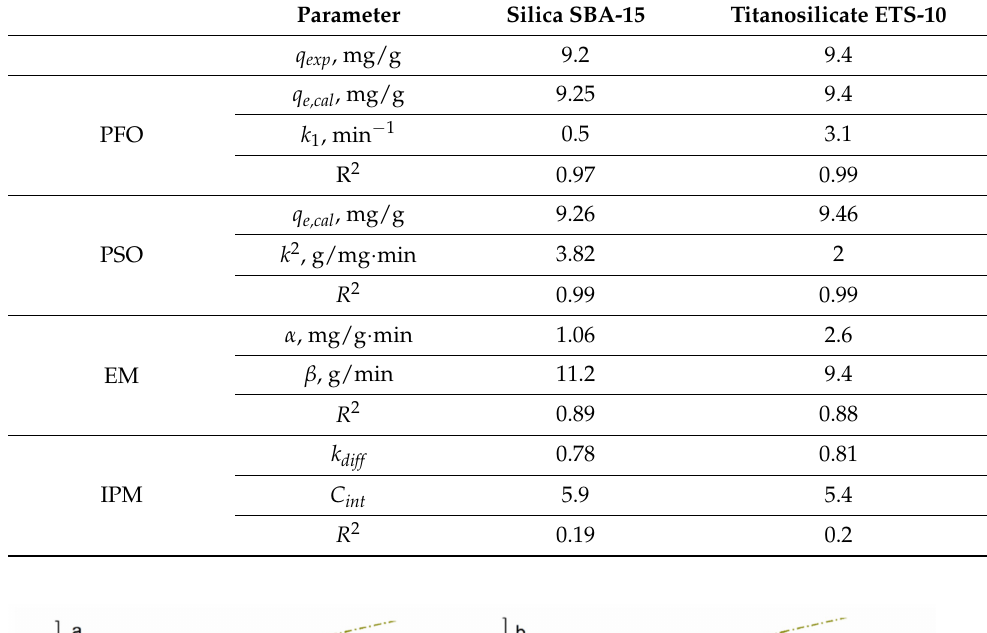
Table 3. Parameters of the applied kinetic models for the sorption of Ce(III).